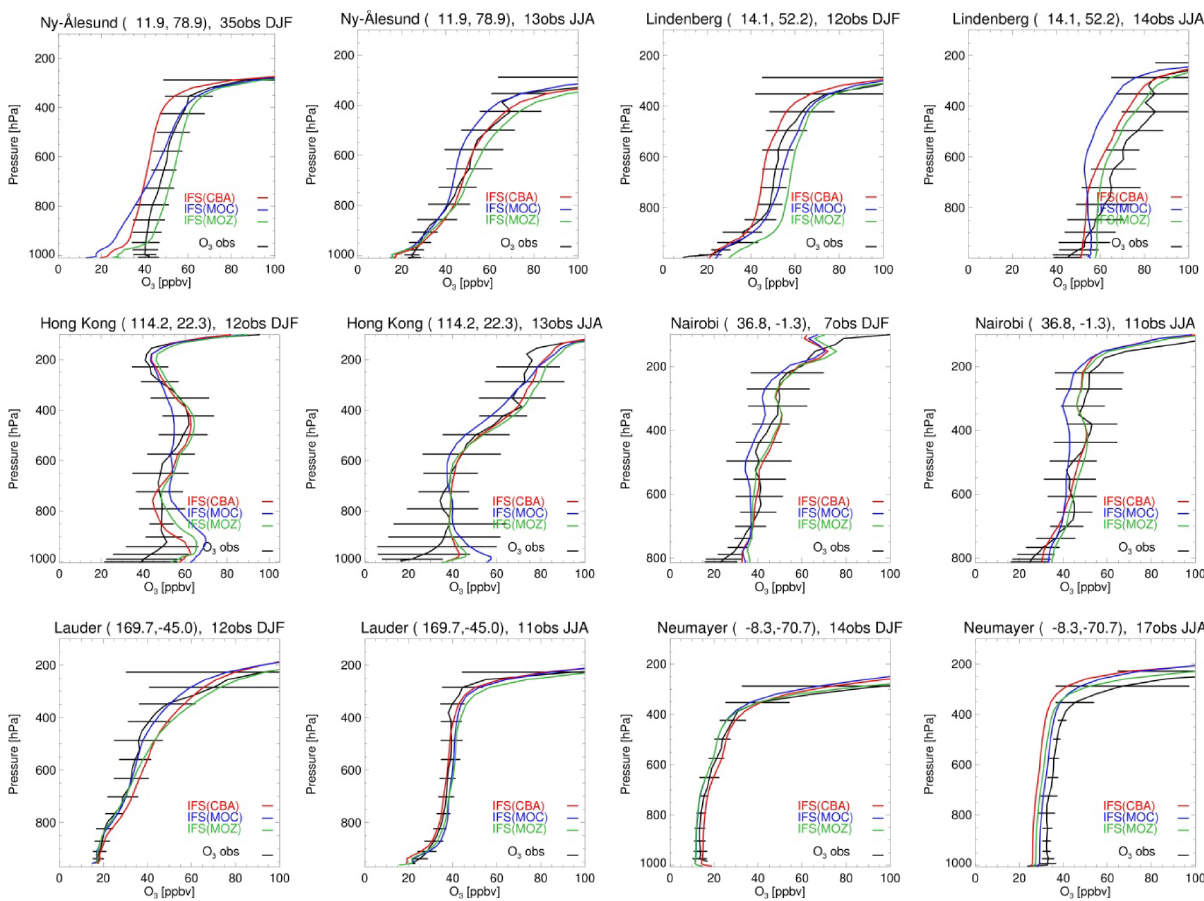
Figure 6. Mean tropospheric ozone profiles from model versions CBA (red), MOC (blue) and MOZ (green) against sondes (black) in volume mixing ratios (ppbv) during DJF and JJA at selected individual stations. Error bars represent the 1 σ spread in the seasonal mean observations.